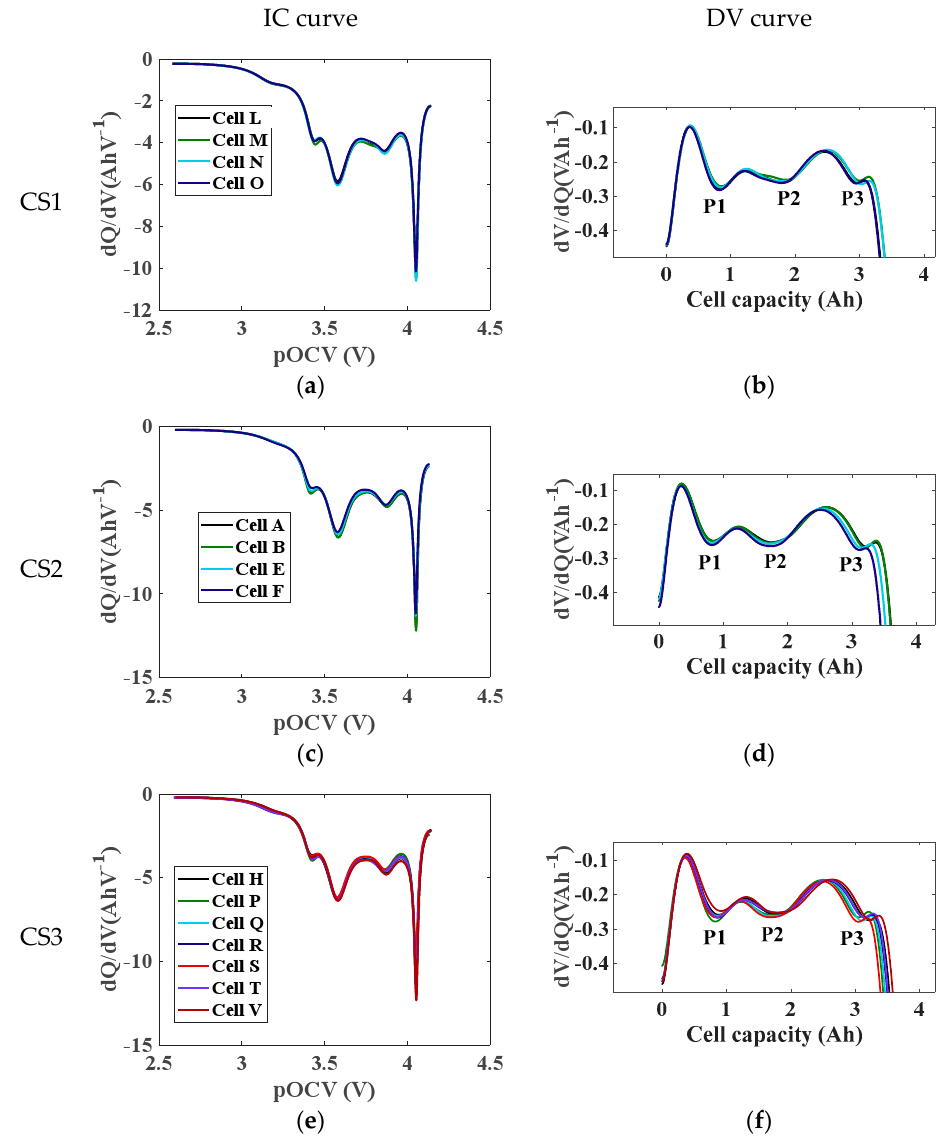
Figure 7. IC-DV curve of the Same DM cell group ( a ) IC ( b ) DV curve of L, M, N & O ( c ) IC ( d ) DV curve of A, B, E & F ( e ) IC ( f ) DV curve of H, P, Q, R, S, T & V.